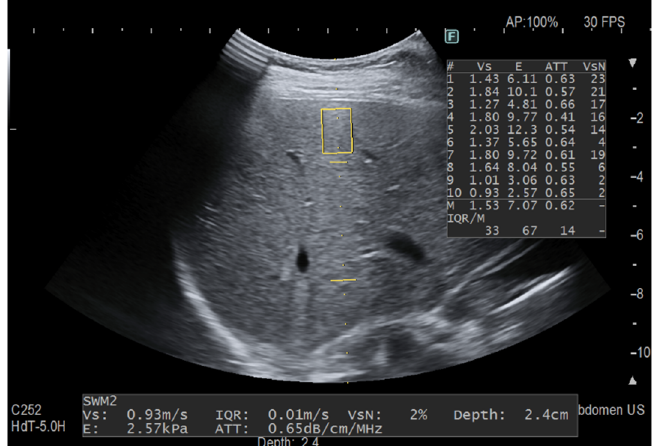
Figure 3. The measurement was taken focusing on the best image for iATT without following the protocol for stiffness assessment. The two horizontal yellow lines graphically show the width (length of each line) and the length (distance between the two lines) of the iATT measurement area, which has a fixed size (length of 4 cm, from 35 to 75 mm from the skin). The yellow rectangle is the region of interest (ROI) for stiffness measurement. Because it is not possible to exclude the stiffness measurement, the stiffness ROI was intentionally positioned close to the liver capsule. This explains the huge variability between consecutive stiffness measurements with an IQR/M = 67% and a VsN always <50%.